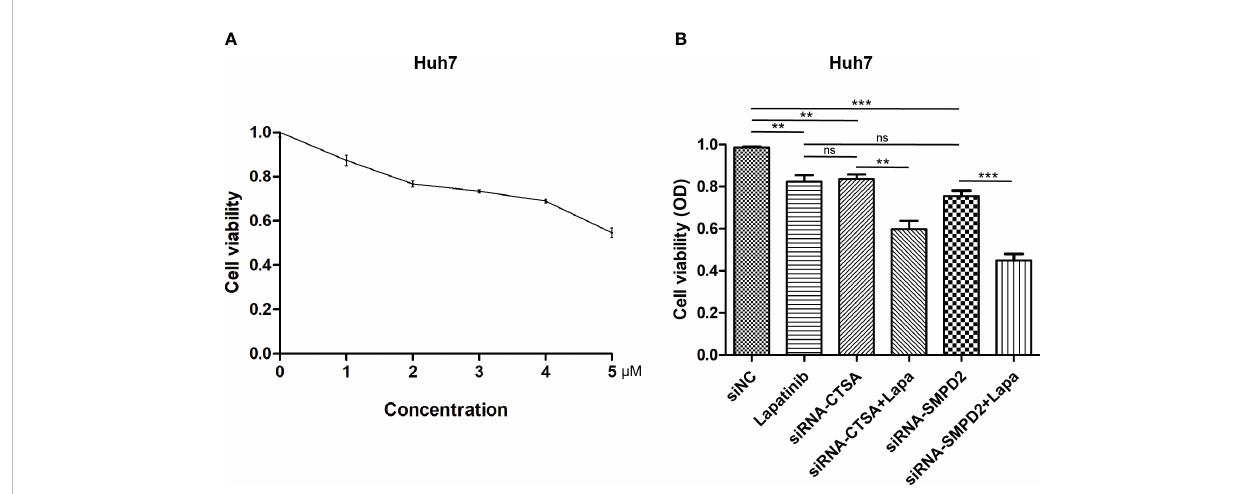
FIGURE 11 Genetic Inhibition of SPGs Sensitizes HCC cells to lapatinib drug. (A) Cytotoxicity at different doses of lapatinib. (B) Cell viability was measured using the CCK-8 assay at 48 hours after treatment with siRNA of CSTA/SMPD2, combined with or without 3 m M lapatinib in Huh7 cells (ns, not signi fi cant; p > 0.05; **p < 0.01; ***p <